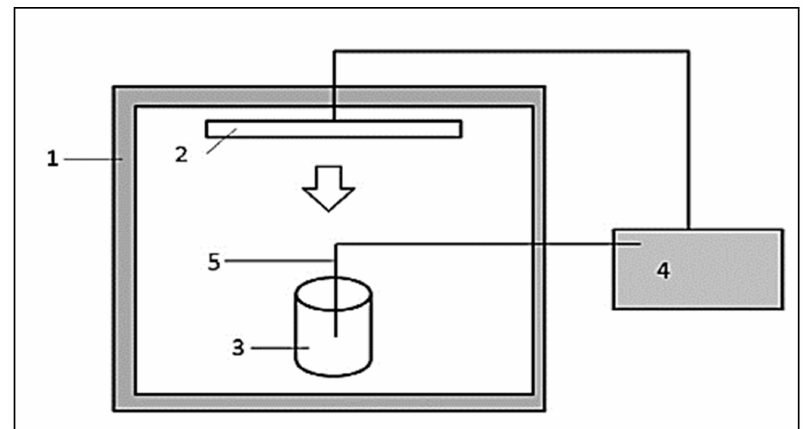
Figure 11. Schematic diagram of an infrared heater for the manufacture of lemon juice. (1) Heating